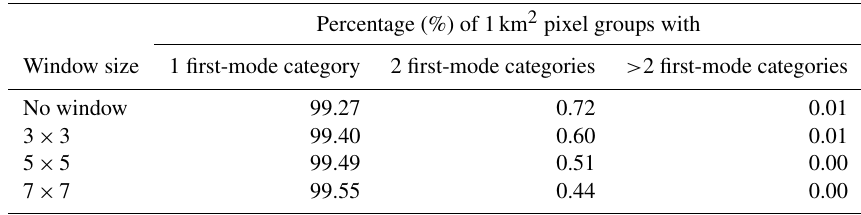
Table B1. Percentage of 1km 2 pixel groups with 1, 2, or > 2 first-mode categories for the 3 × 3, 5 × 5, and 7 × 7 smoothing moving windows and without the window